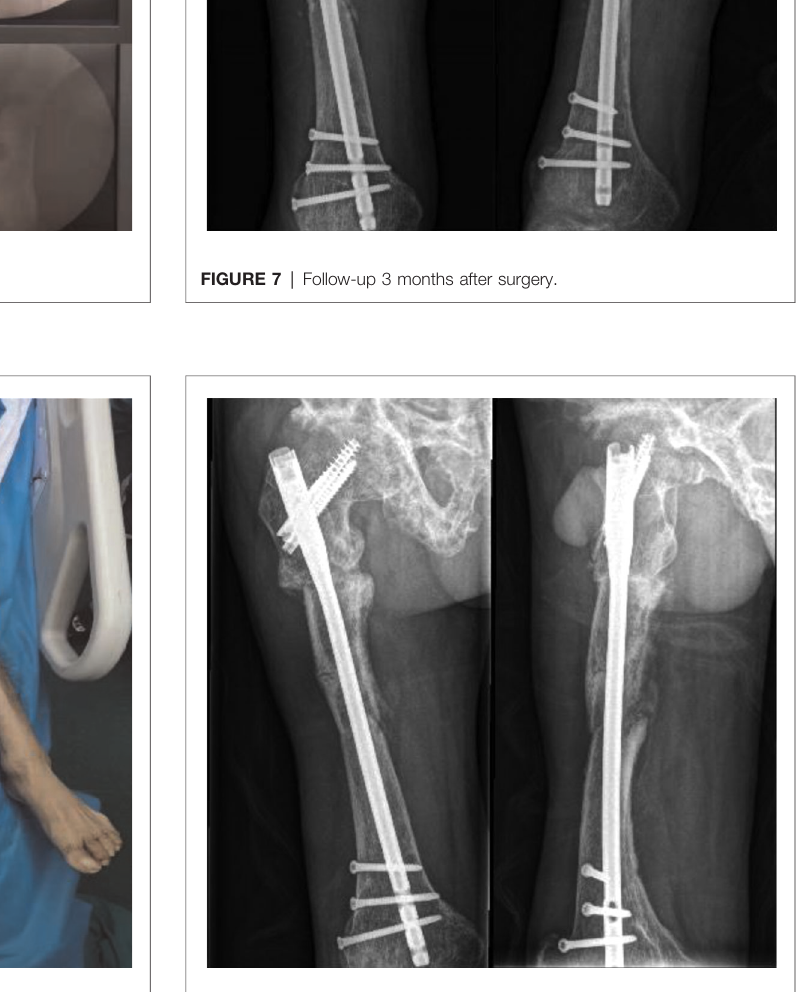
FIGURE 8 | 6 months after the operation, the fracture line was further